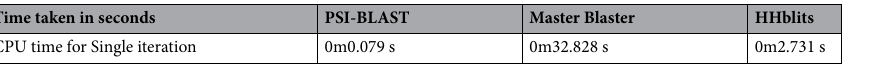
Table 6. CPU time taken to search sequence having average length of 200 amino acids against SCOP70 database having 13,650 domains with an E-value of 0.001 and query coverage of 70%. The computations are performed at CDAC Bangalore on the supercomputing facility having Linux 64-bit